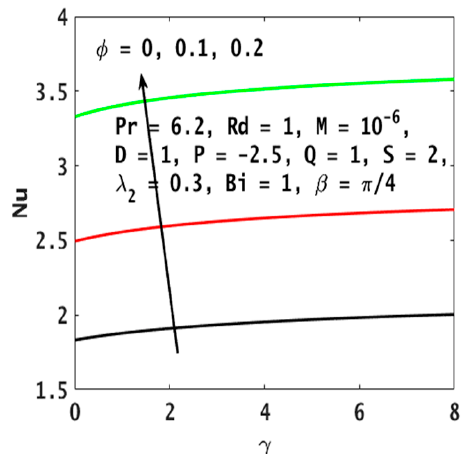
Figure 5. Variation of C f with P. Crystals 2021 , 11 , x FOR PEER REVIEW